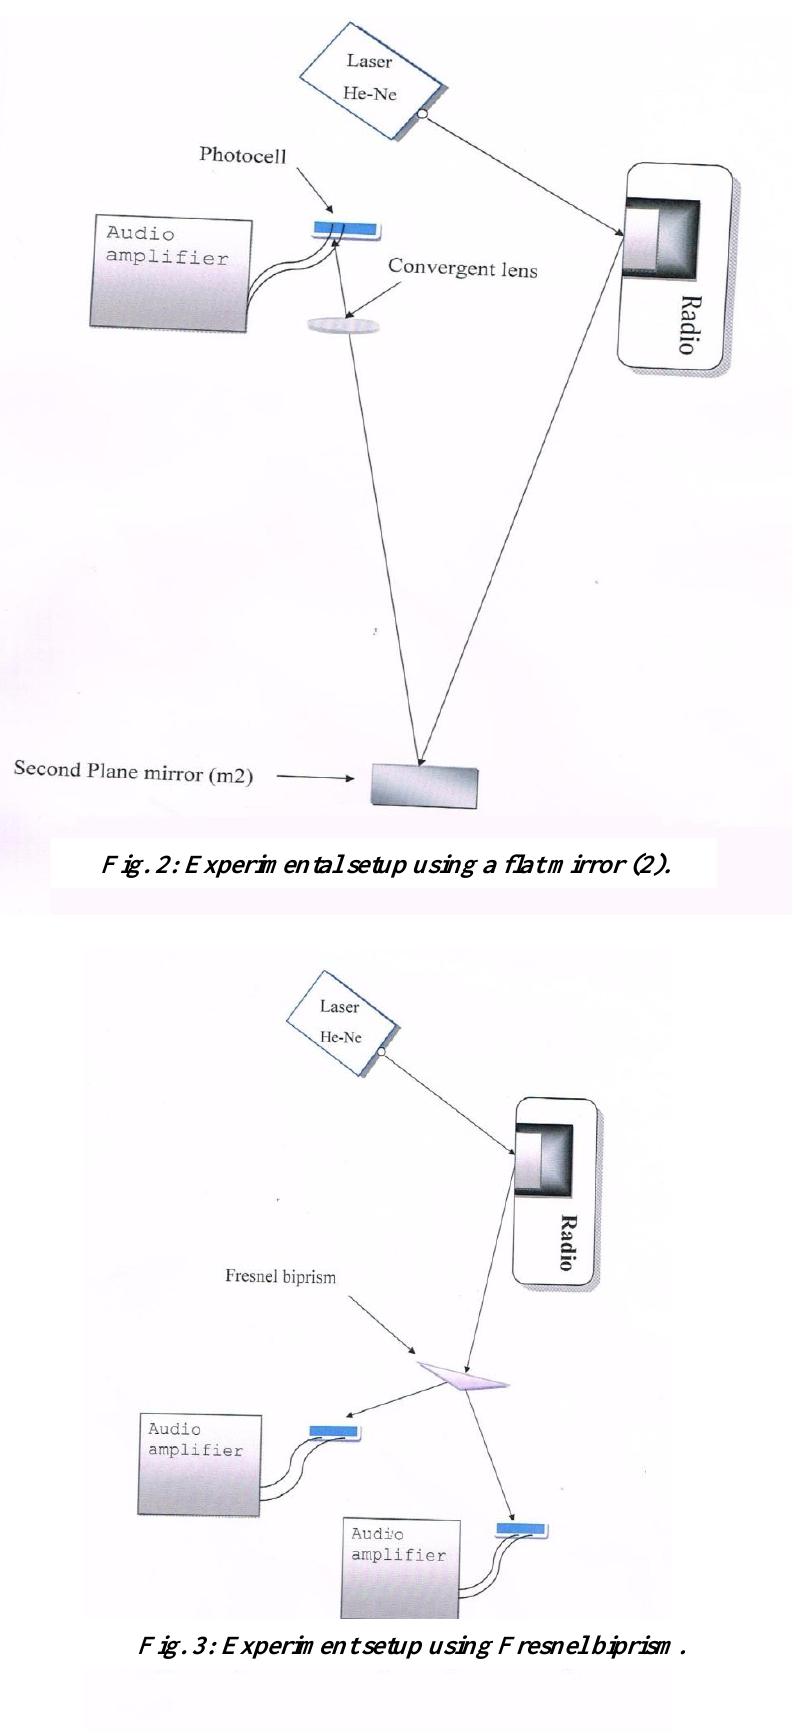
Fig. 3: Experiment setup using Fresnel